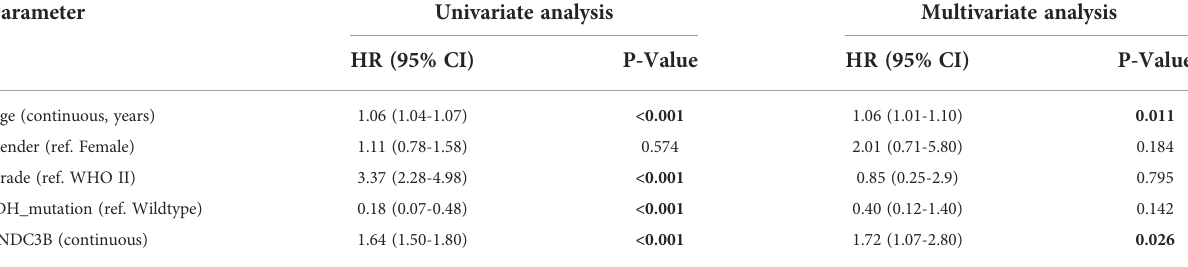
TABLE 2 Univariate and multivariate cox regression analyses of prognostic factors in 416 cases of low-grade glioma (LGG).